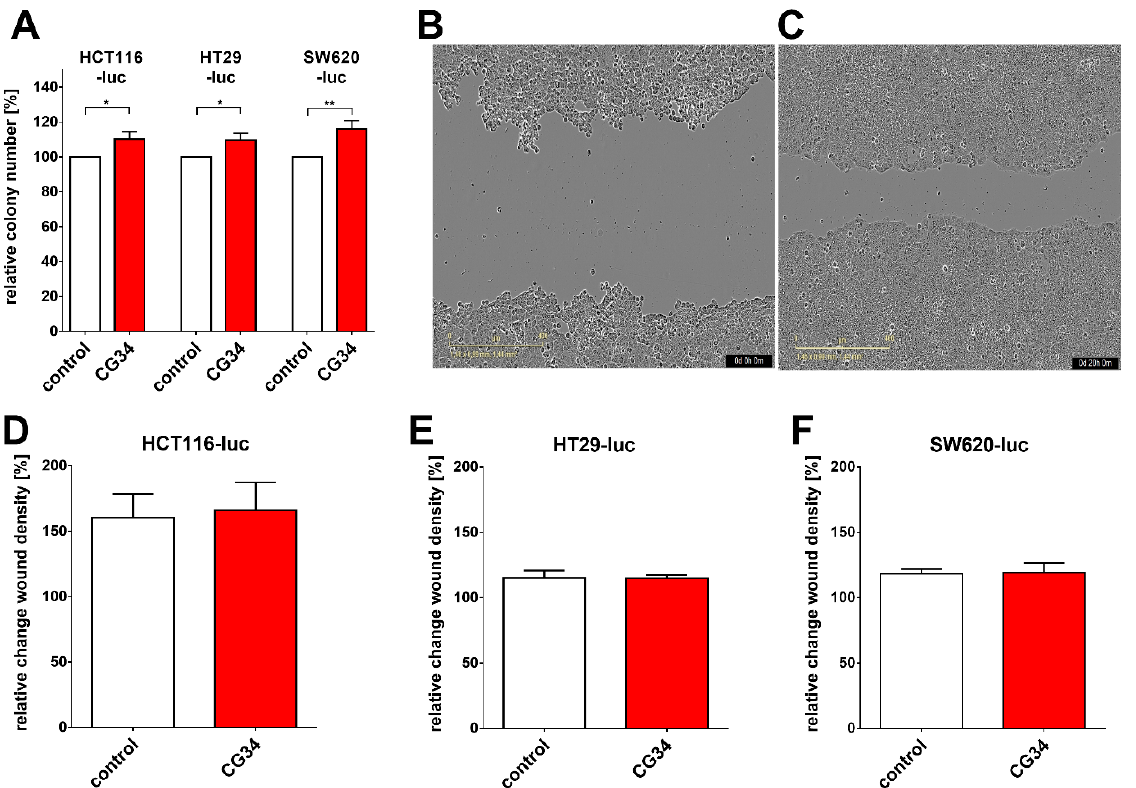
Figure 4. Influence of the chemerin peptide analog CG34 versus control (medium only) on colony formation and migration of three luciferase-expressing colorectal carcinoma cell lines (HCT116-luc, HT29-luc, SW620-luc). ( A ) Results of the colony formation assay. Colony formation data represent mean ± SD of n = 3–4 independent experiments performed in triplicate. Statistical significance was determined with an unpaired t -test; * p < 0.05, ** p < 0.01. ( B ) Exemplary image of a migration experiment at the start of treatment (0 h). ( C ) Image of the same well as in ( B ), taken 20 h later. ( D – F ) quantitative results of the migration assay: ( D ) HCT116-luc; ( E ) HT29-luc; ( F ) SW620-luc. Migration data represent mean ± SD of n = 4 inde- pendent experiments performed in